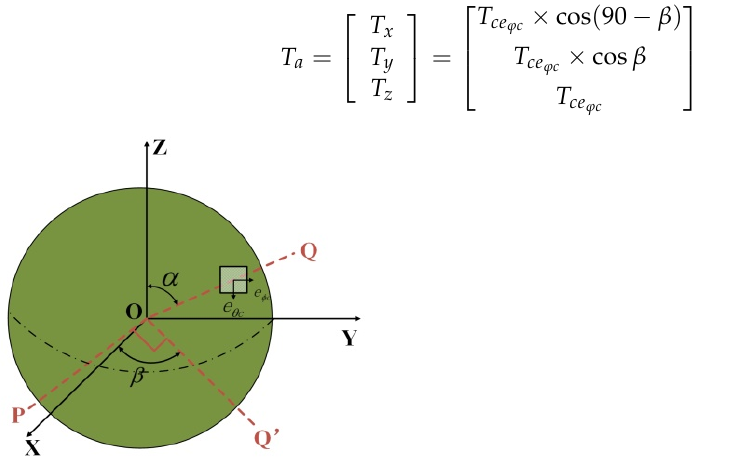
Figure 13. Torque decomposition.